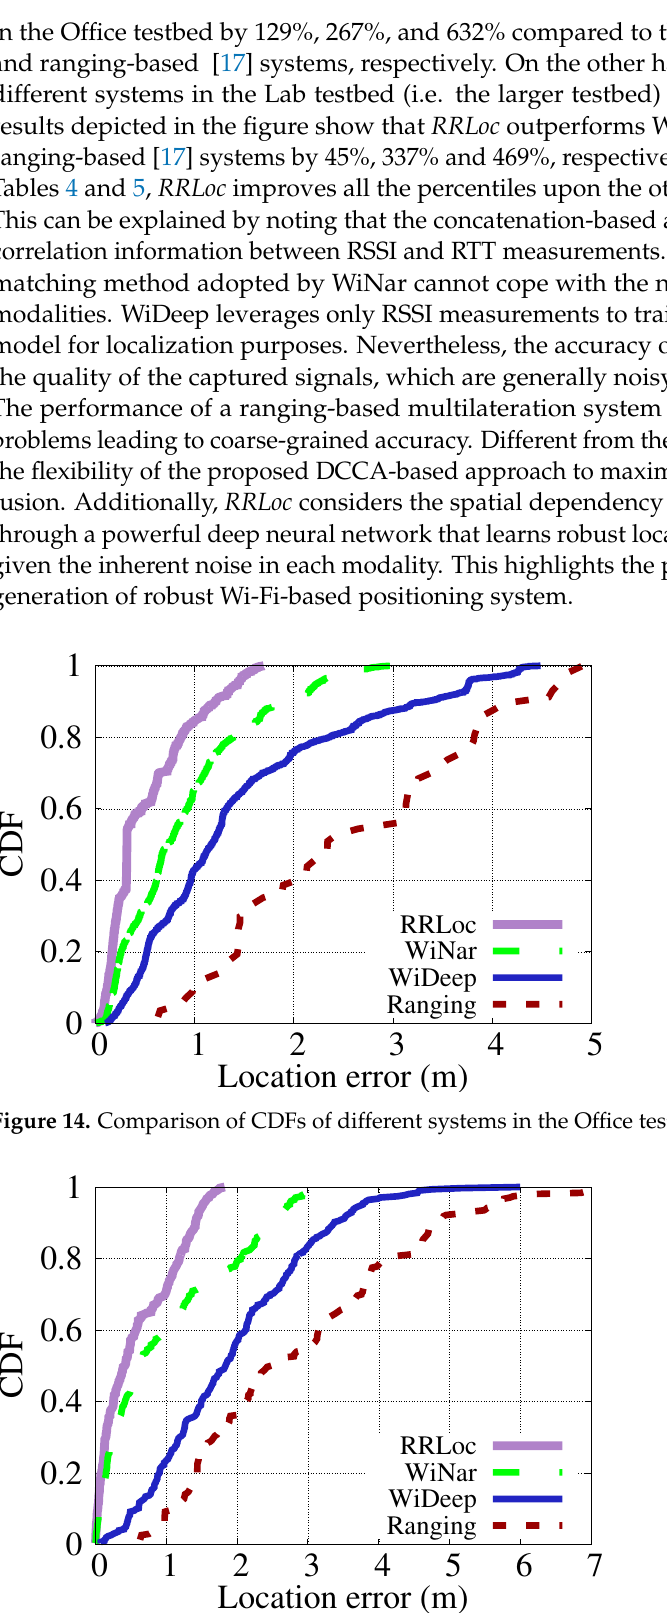
Figure 15. Comparison of CDFs of different systems in the Lab